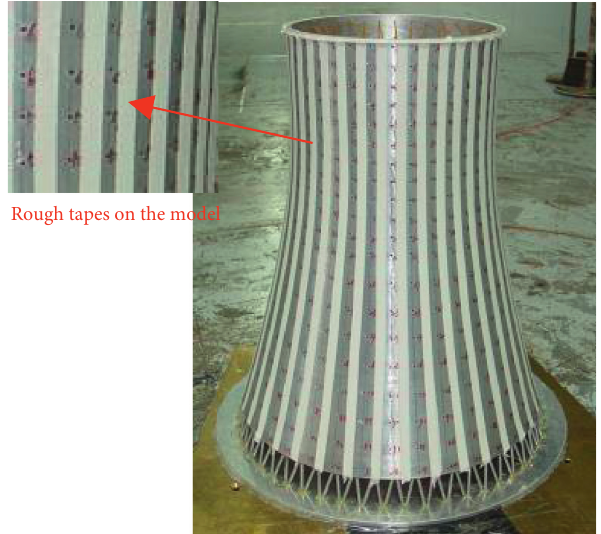
Figure 4: Roughness simulation of the cooling tower